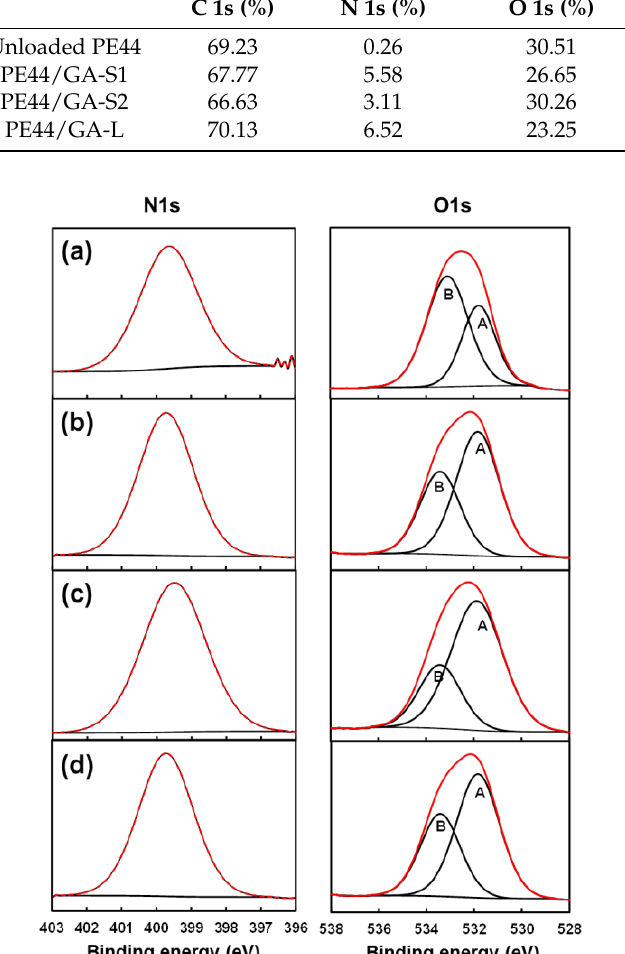
Figure 6. High-resolution XPS spectra for ( a ) unloaded PE44, ( b ) PE44/GA-S1, ( c ) PE44/GA-S2 and ( d ) PE44/GA-L: N 1s and O 1s regions. The red line corresponds to the experimental profile while the black lines are the peaks from deconvolution.